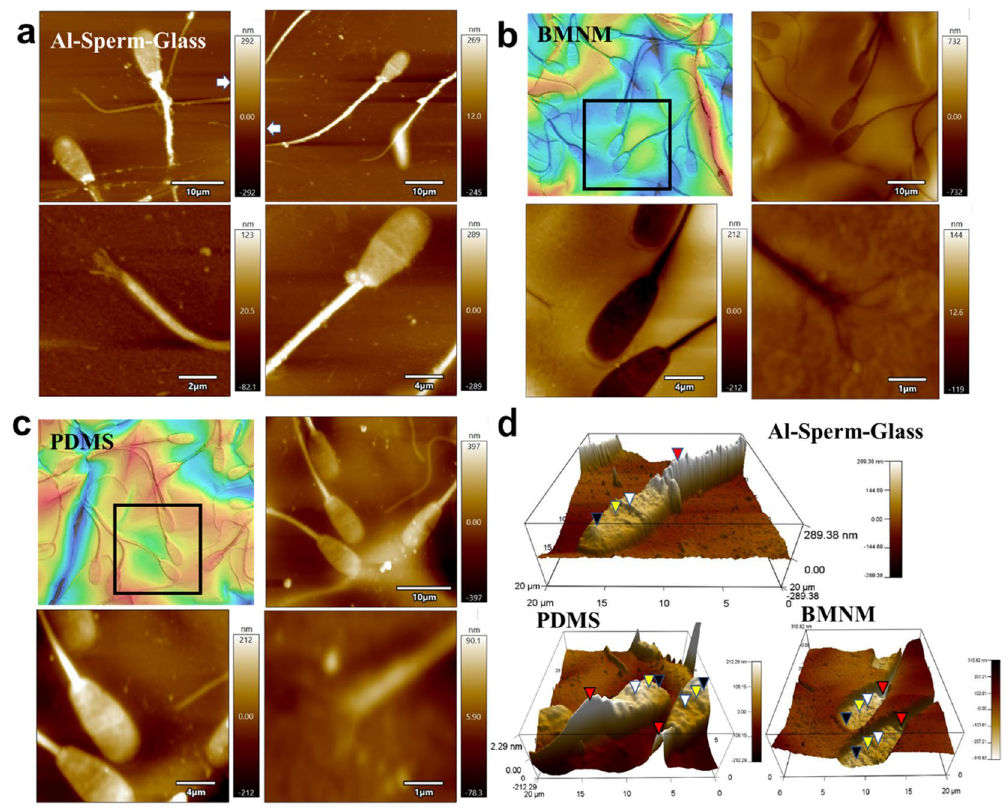
Figure 4. Analysis of various structures of sperm surface. ( a ) Atomic force microscopy analysis of sperm from head to tail after Al thin film deposition. White squares show areas analysed in greater detail. ( b and c ) Examination of surface morphology of the sperm stored in biomimetic metal nano-moulds (BMNM) and shape reproduced on dimethylpolysiloxane (polydimethylsiloxane, PDMS) using AFM. Laser microscopy image focusing on sperm shown in black frame. ( d ) Height analysis of AFM image and three-dimensional height mapping. Triangles show microstructure of the sperm head. Black = acrosome, yellow = equatorial segment (EqS), white = necklace, red =